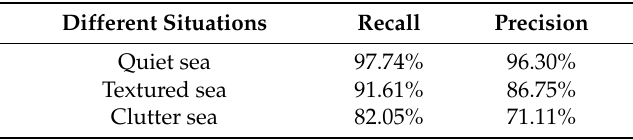
Table 1. Detection results of our method in various